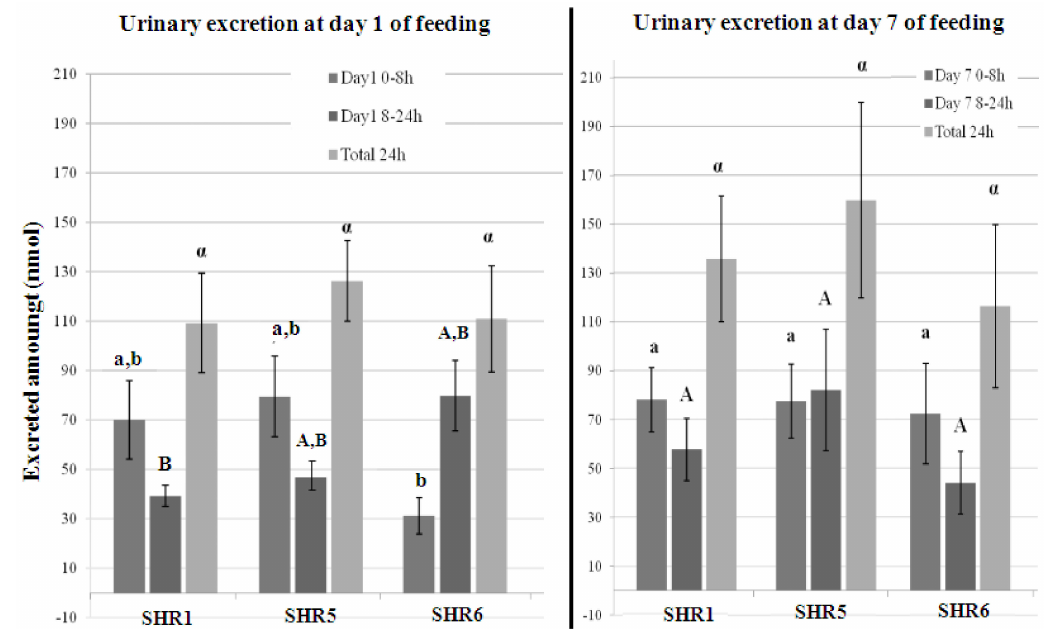
Figure 2. Total urinary metabolites excreted at days 1 and 7, 0–8 h, 8–24 h and 0–24 h after ingestion of grape pomace extracts. SHR rats fed with: SHR1, Grenache (GRE1) EA70 seed pomace extract; SHR5, Mourv è dre (MOU) EA70 skin pomace extract and SHR6, Alicante